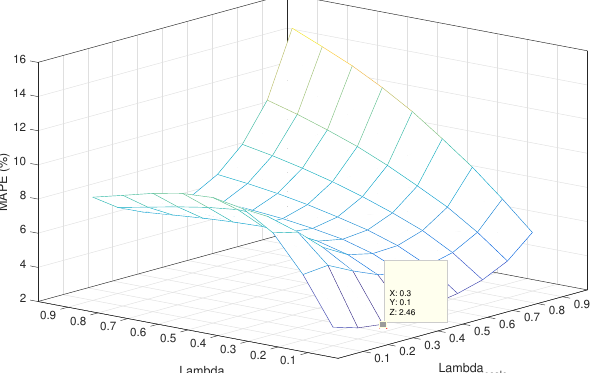
Figure 2. Parameters of the robust exponential smoothing model. MAPE: mean absolute percentage